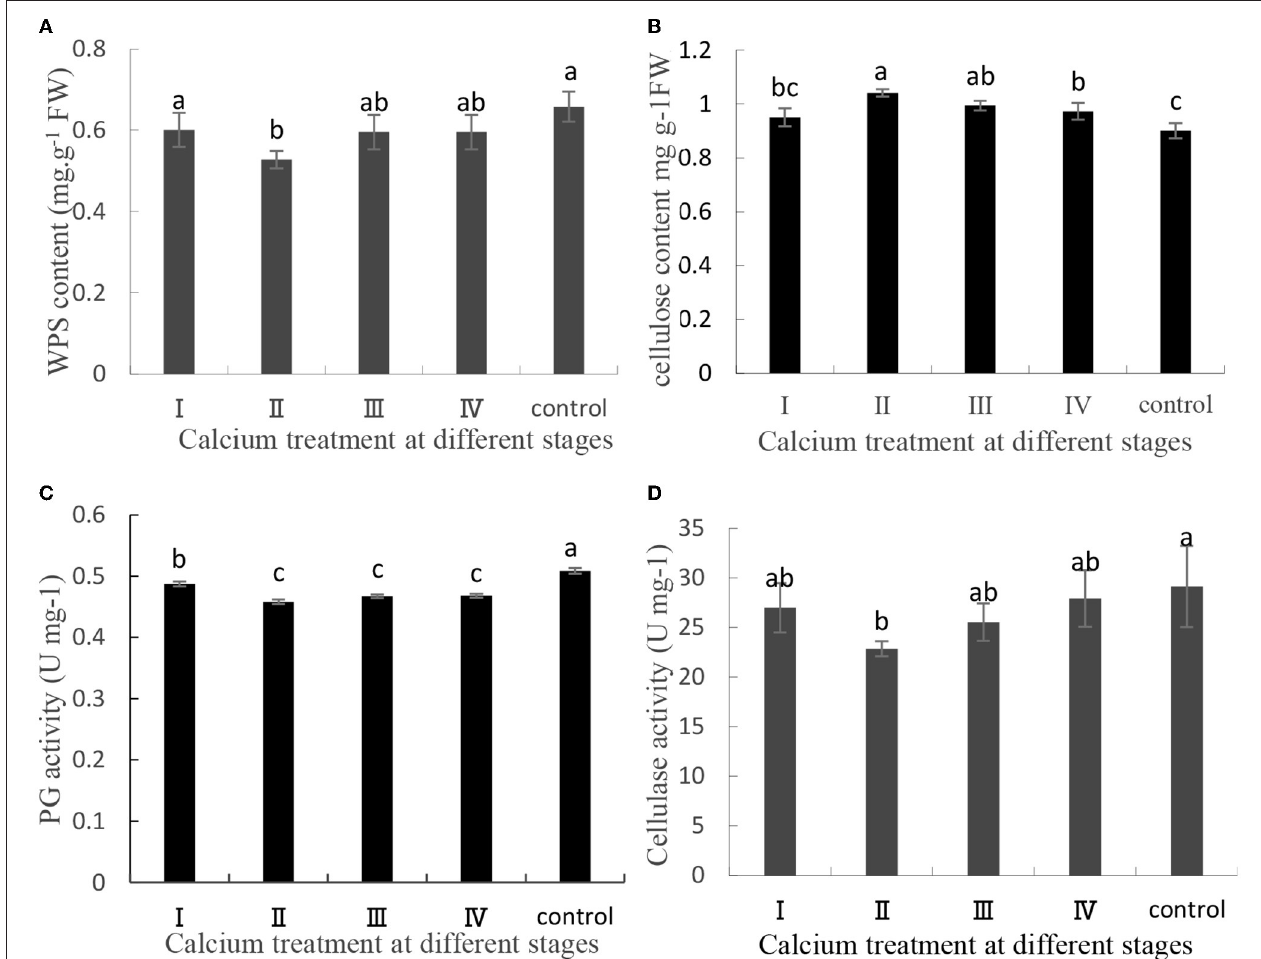
FIGURE 2 | (A) Water-soluble pectin content, (B) cellulose content, (C) PG activity, and (D) cellulase activity contents of the grape berry peel. Data are presented as mean ± standard. Lowercase letters represent significant differences ( P < 0.05).